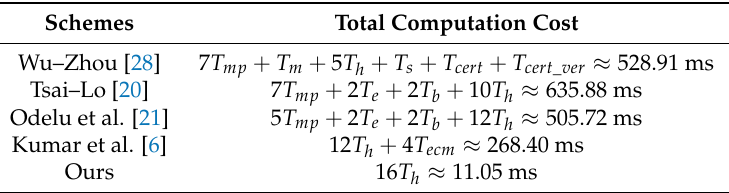
Table 6. A comparative summary: computation